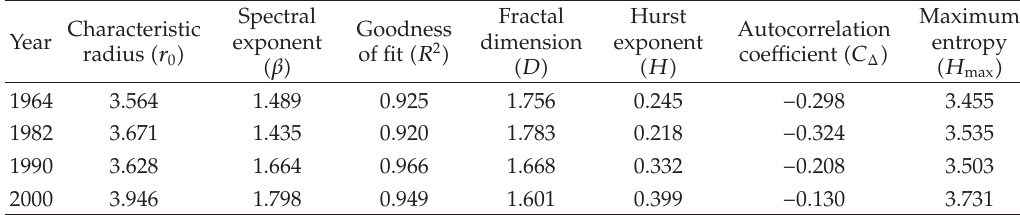
Table 2: Estimated values of model parameters and related statistics of Hangzhou urban density. The characteristic radius (cid:6) r 0 (cid:7) values are estimated by means of least squares computation based on (cid:6) 2.2 (cid:7) , and using r 0 values, we can compute the maximum entropy with the formula H max (cid:8) e ln r 0 . The unit of entropy is “nat.” Characteristic Year radius (cid:6) r 0 (cid:7)